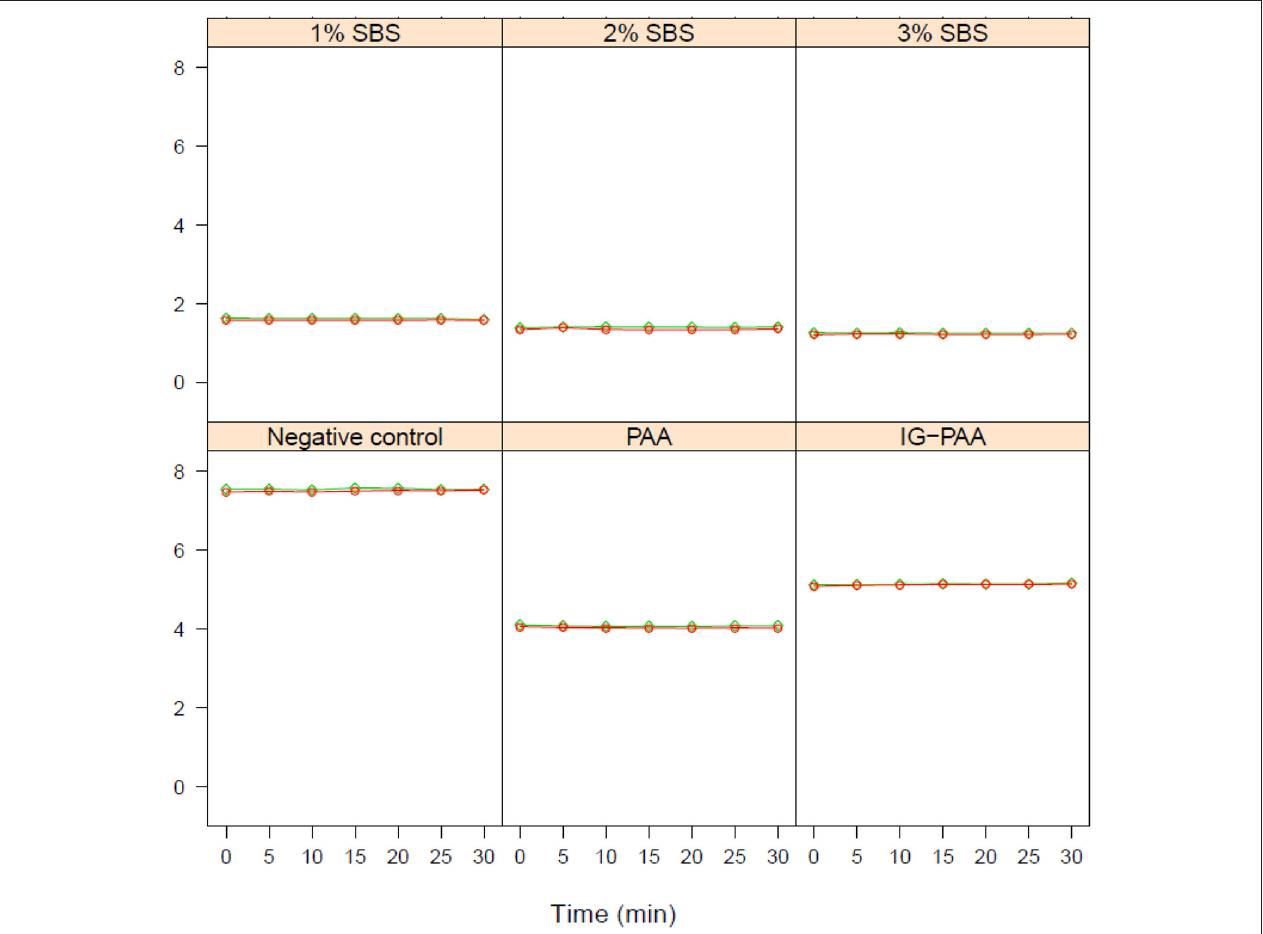
FIGURE 2 | Impact on reuse water pH over time. The pH of reuse water with or without Salmonella Typhimurium inoculation after treatment with acidifiers. The average pH over three replicates at each time point is reported. S. Typhimurium was inoculated at time point zero at a concentration of 3 × 10 7 CFU/mL. The green diamonds represent pH of reuse water with S. Typhimurium. The red circles represent pH of reuse water without Salmonella addition. These data points are similar enough that overlaps occur.